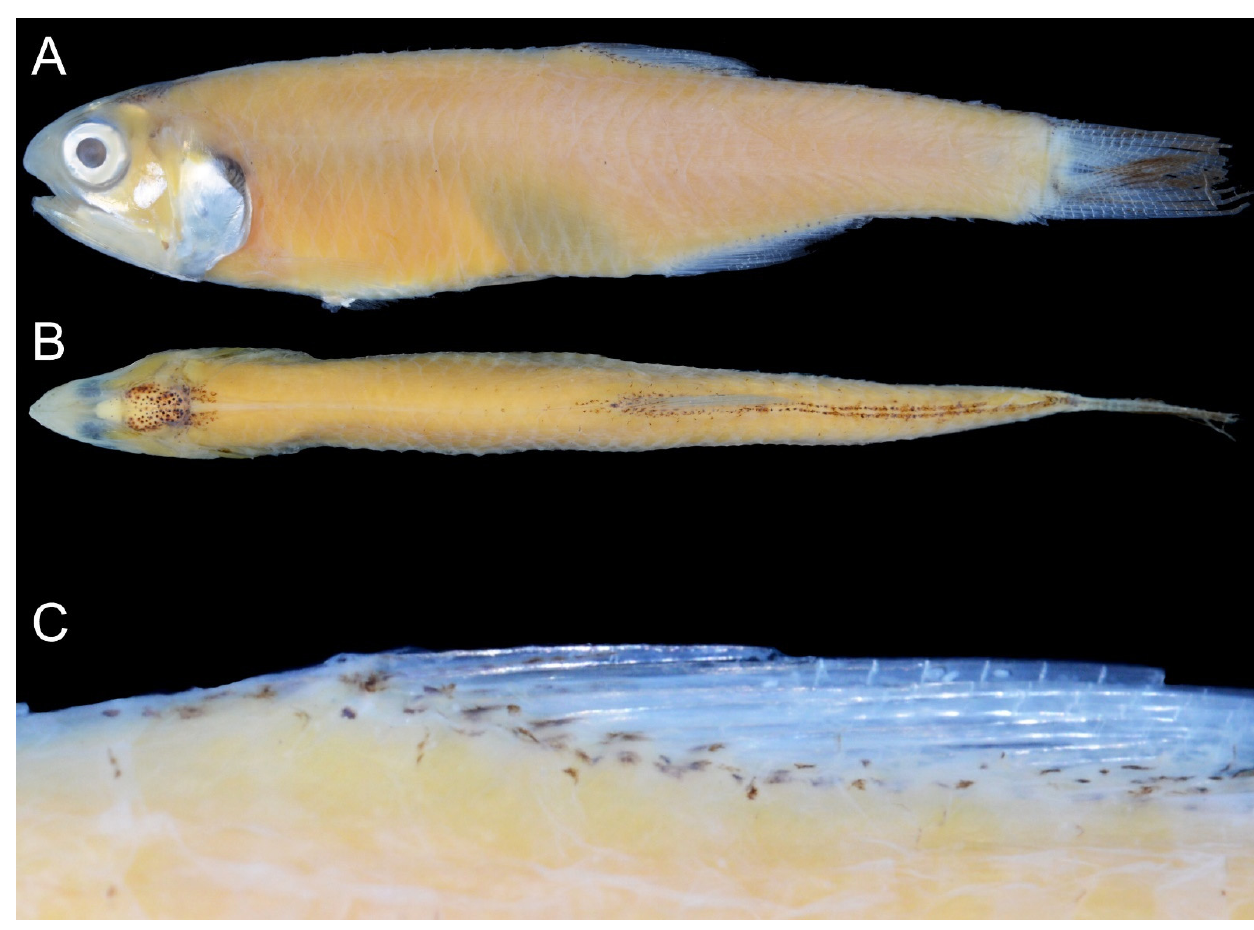
Figure 3. ( A ) Lateral and ( B ) dorsal views; and ( C ) dorsal-fin origin (without scute) of the holotype of S. hindustanensis n. sp. (BMNH 1969.4.22.1648, 53.1 mm SL, Mumbai, India). Stolephorus insularis (not of Delsman): Whitehead et al., 1988 [4] (in part): 413 (north- western part of India).